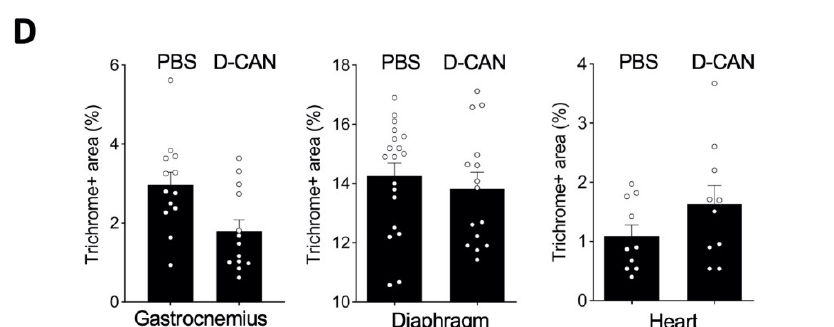
Figure 4. ( A ) A snapshot of the treadmill test revealing increased endurance of mdx mice treated with D-CAN. ( B ) The timeline of experiment showing endurance improvement in mdx mice treated with D-CAN graphed underneath. Work at timepoint 1 was set as 1, and relative change at timepoint 2 is shown. N = 3. * p < 0.05. ( C ) Masson’s trichrome staining of gastrocnemius muscle from individual mice showing less regression and disorganization of fibers in D-CAN-treated mice. ( D ) Quantification of Masson’s trichrome staining-positive area in gastrocnemius, diaphragm, and cardiac muscle, N > 12. Scale bar: 50 µm.